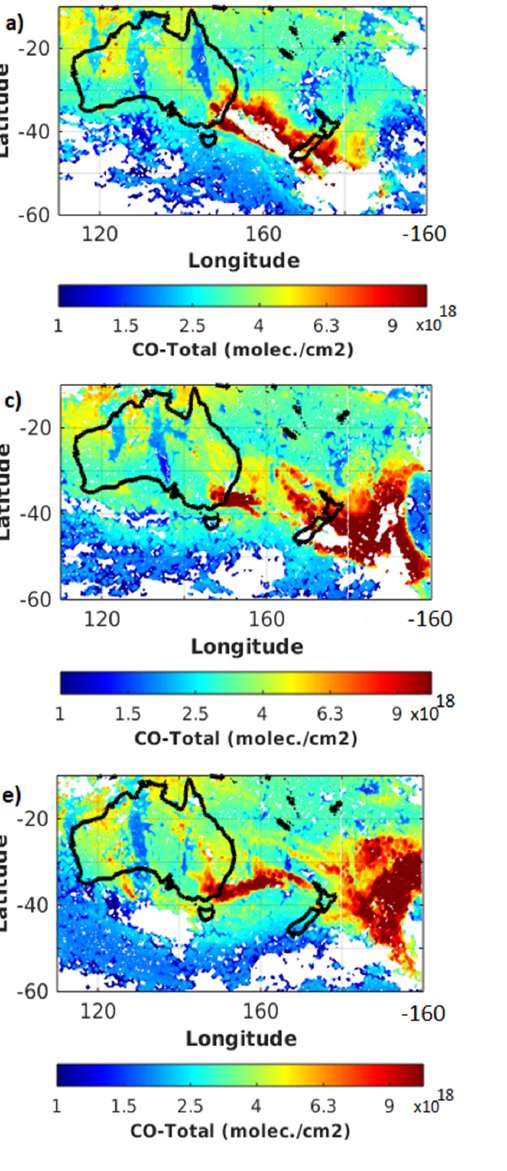
Figure 4. Daily maps of CO total columns ( a , c , e ) obtained from IASI observations and AAI ( b , d , f ) from GOME-2 observations recorded on the 31 December 2019 (top), 1 January 2020 (middle) and 2 January 2020 (bottom).